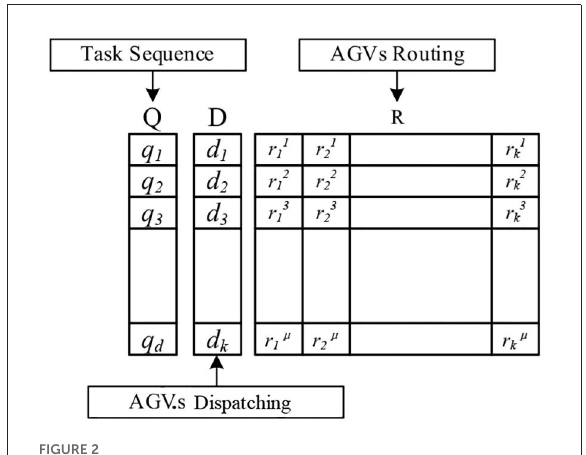
FIGURE2 State space representation.